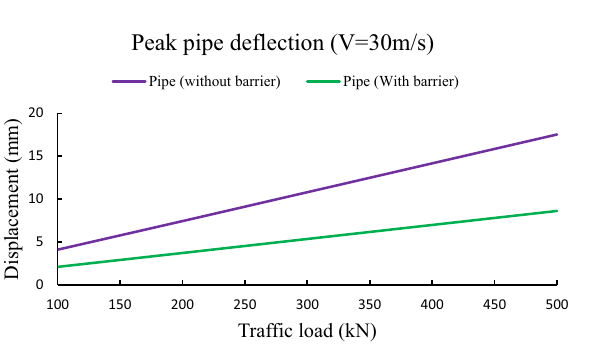
Figure 7. Influence of traffic load on peak pipe